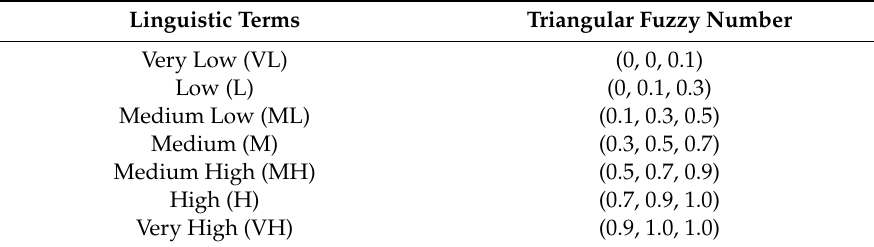
Table 17. Linguistic scale for the weights.